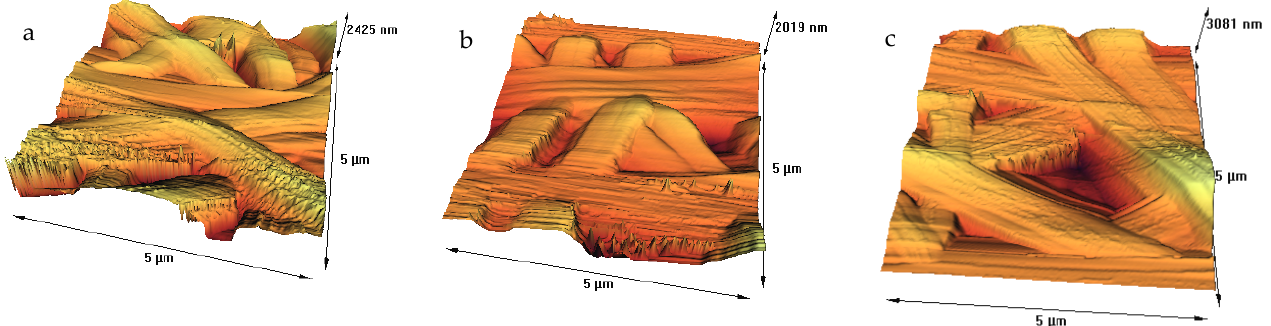
Figure 2. Atomic force microscopy (AFM) images of: ( a ) nanofibers before plasma treatment, ( b ) nanofibers after treatment with argon plasma and ( c ) nanofibers after treatment with argon–oxygen plasma. Table 1. Roughness values as a function of plasma treatment on crosslinked gelatin nanofibers